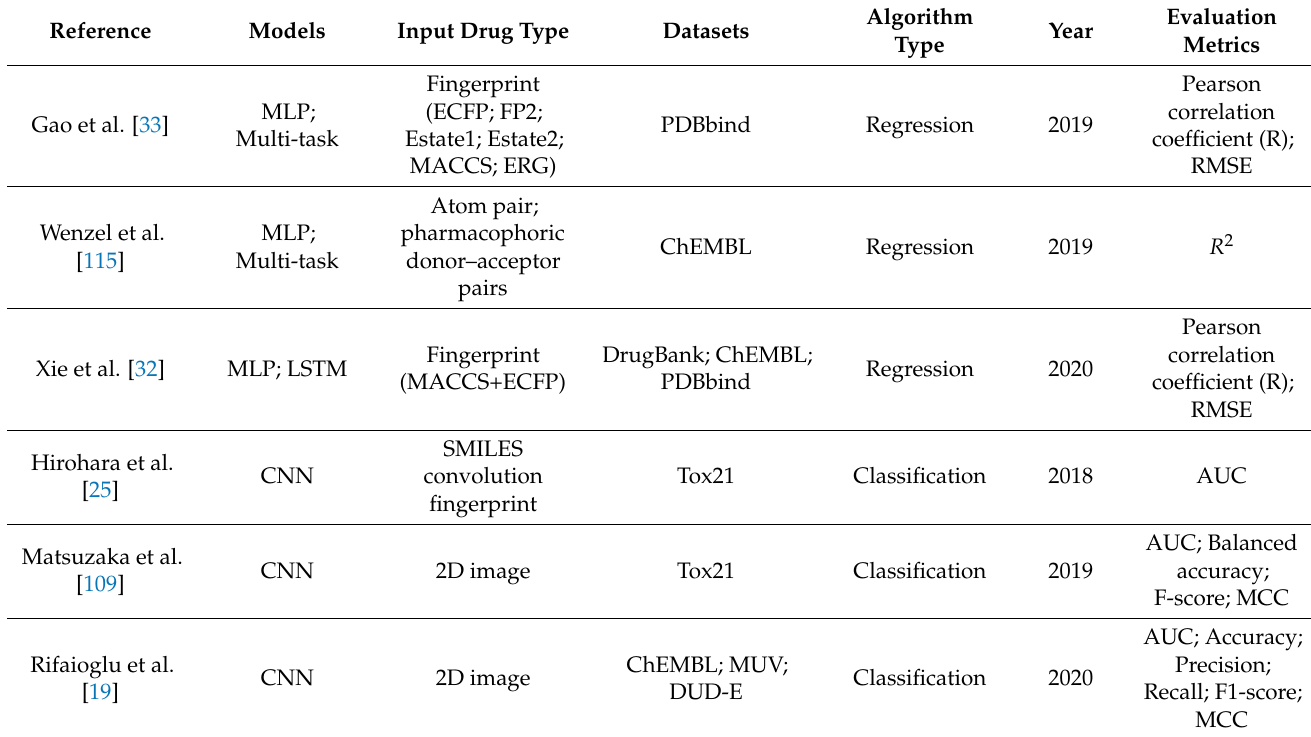
Table A1. Ligand-based DL methods for DTI